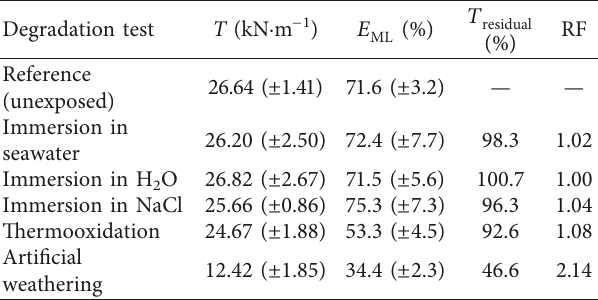
The 95% confidence intervals are given in